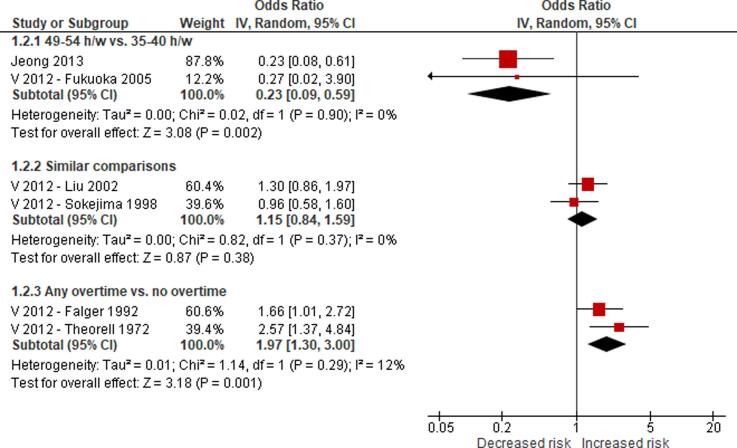
Supporting meta-analysis of deprioritized evidence (case-control studies), Outcome: Acquired ischaemic heart disease, Comparison: Worked 49–54 h/week compared with worked 35–40 h/week (or similar comparisons, or any overtime work). Footnotes: The similar comparisons included in the meta-analysis were: Virtanen 2012 - Liu and Tanaka, 2002: 41 to 60 h/w vs. ≤40 h/w and Virtanen 2012 - Sokejima 1998: 9.01 to 11.00 h/d vs. 7.01 to 9.00 h/d.